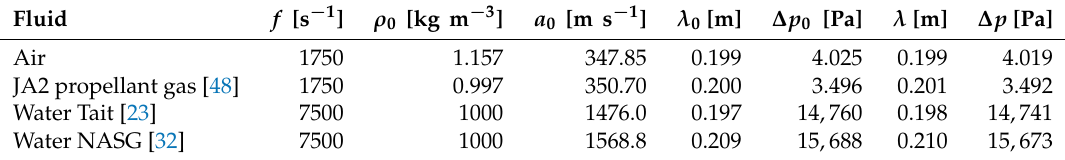
Table 2. The excitation frequency f of the acoustic waves, the reference density ρ 0 and the associated speed of sound a 0 at the reference pressure of p 0 = 10 5 Pa, the wavelength λ 0 and pressure